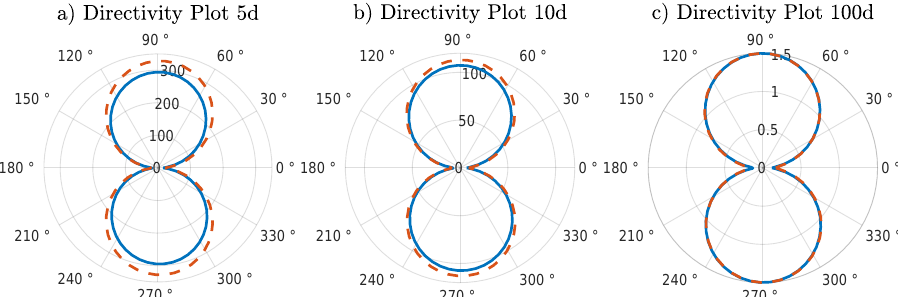
Figure 12. Directivity plot of the p rms [Pa] determined by the linear solution of the FW-H equation on points placed on concentric circles at ( a ) r = 5 d , ( b ) r = 10 d and ( c ) r = 100 d . Solid line, rigid cylinder; dashed line, flexible cylinder.